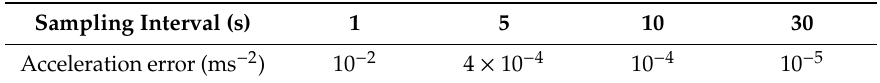
Table 1. Acceleration accuracy requirements for di ff erent sampling intervals with an ∆∆ the 1-cm